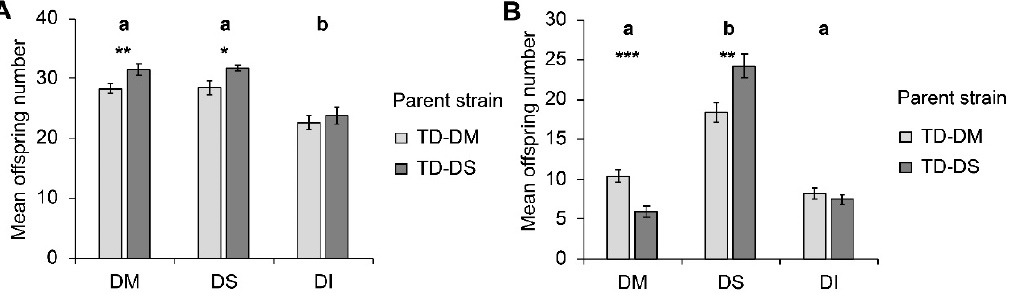
Figure 1. Mean (± SE) number of offspring produced by Trichopria drosophilae from strains reared for >30 generations on Drosophila melanogaster (light grey) or on Drosophila suzukii (dark grey) on different host species under ( A ) no-choice and ( B ) choice conditions. DM: D. melanogaster ; DS: D. suzukii ; DI: D. immigrans . Different letters above bars indicate significant differences between host species at the 5% level (generalized linear model (GLM) ( A ) and generalized linear mixed model (GLMM) ( B ), followed by sequential Bonferroni post hoc tests), stars indicate significant differences between parasitoid strains at the p -level of 0.001% (***), 0.01 (**), or 0.05 (*) (Mann–Whitney U test).